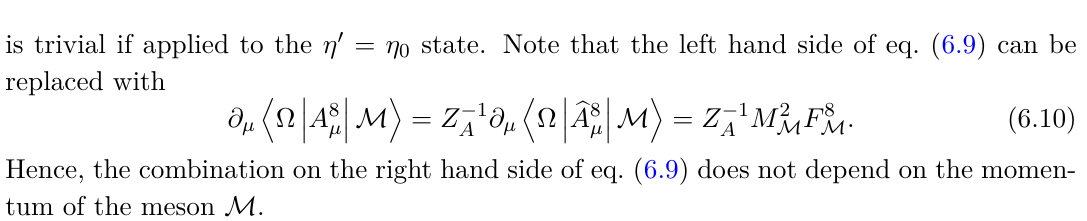
Figure 6. Check of the octet AWI (6.9) for the η and η 0 states. Light points correspond to the case when the singlet contribution to the octet AWI is